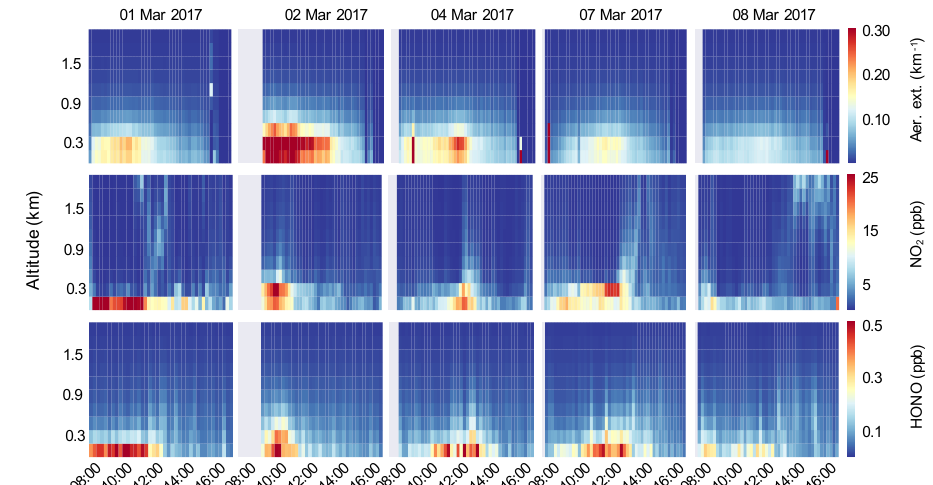
Figure 5. Example vertical profile time series, plotted as heat maps with altitude on the y axis, for selected mostly sunny days in early March 2017. The top row shows aerosol extinction, the middle row the NO 2 mixing ratio and the bottom row the HONO mixing ratio.